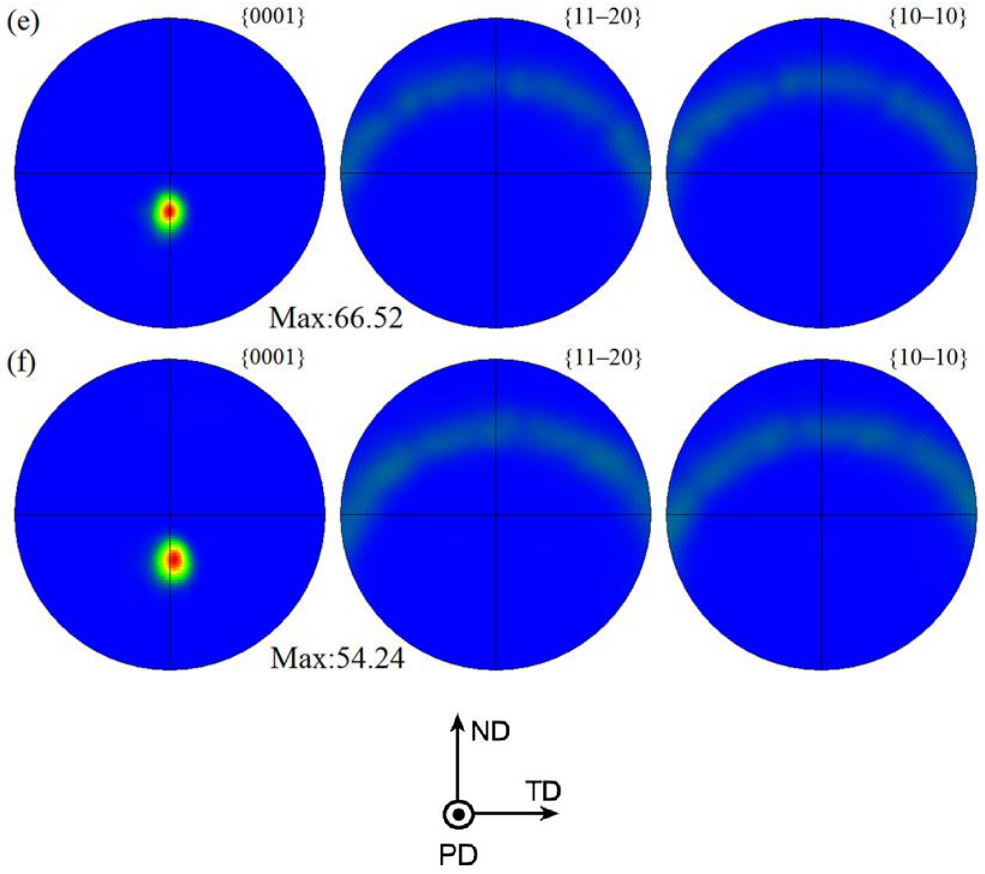
Figure 6. Pole figures of different SZ regions in FSP Mg–6Sn–2Zn samples: ( a ) SZ-up region at 60 mm/min; ( b ) SZ-down region at 60 mm/min; ( c ) SZ-up region at 90 mm/min; ( d ) SZ-down region at 90 mm/min; ( e ) SZ-up region at 120 mm/min; and ( f ) SZ-down region at 120 mm/min .